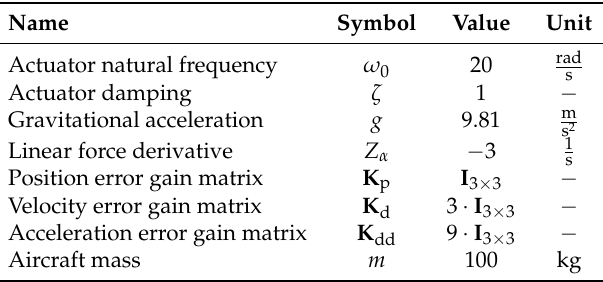
Table 1. Constants used in the simulation